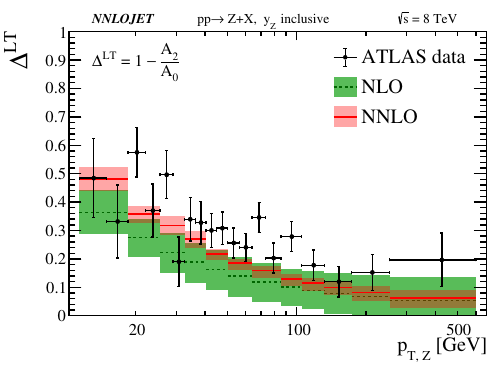
Figure 12 . The extent of the Lam-Tung violation as expressed through (cid:1) LT for the ATLAS data p in pp collisions at s = 8 TeV. The data is compared to the corresponding NLO (green (cid:12)ll) and NNLO (red (cid:12)ll) predictions.